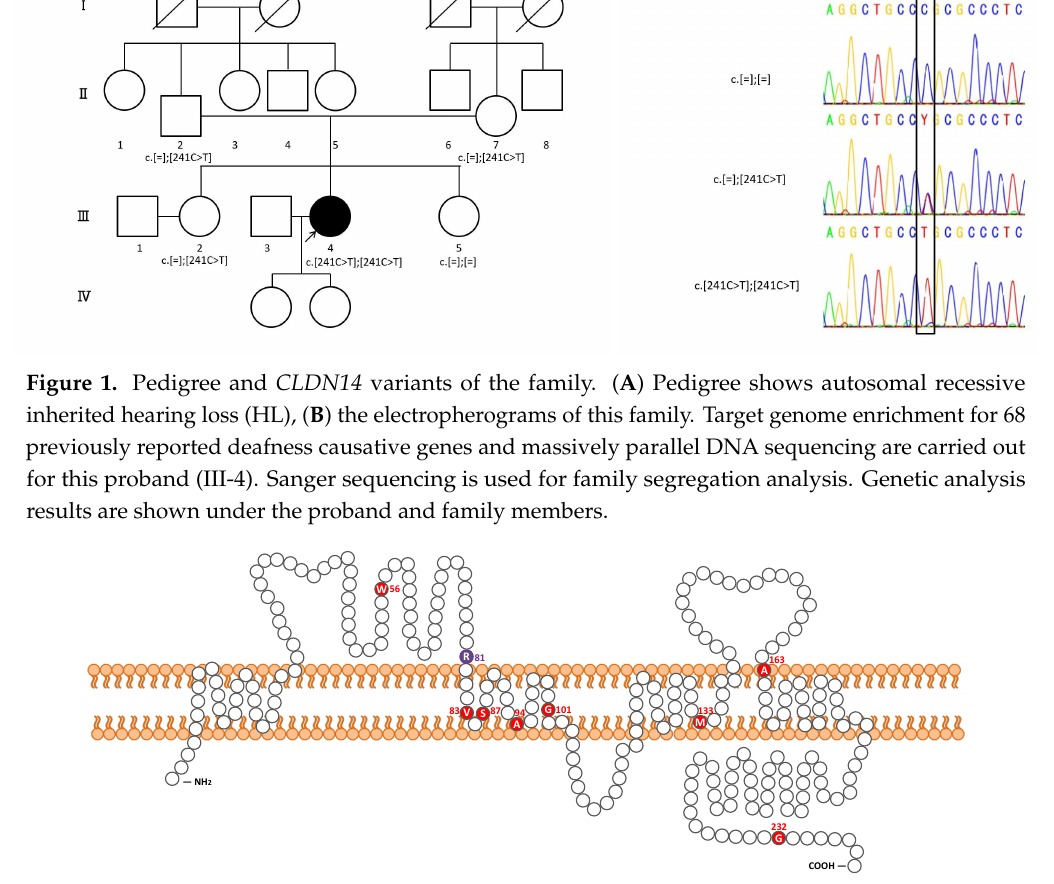
Figure 2. Location of pathogenic variants in Claudin-14. Red colored amino acid residues indicate previously reported claudin-14 variants. The blue colored residue indicates the positions of CLDN14 p.Arg81His and p.Arg81Cys.